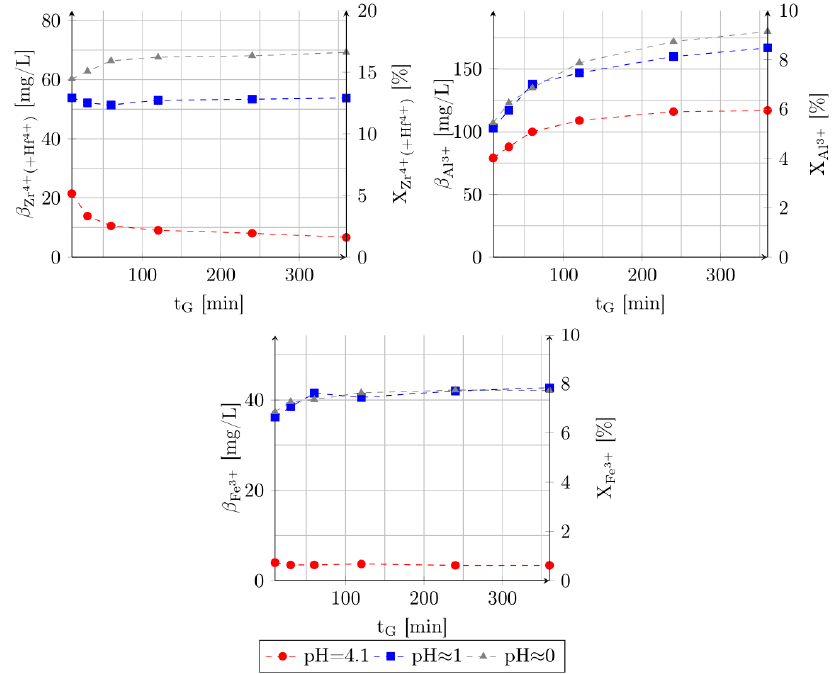
/ m conc. = 15mmol / g; H +